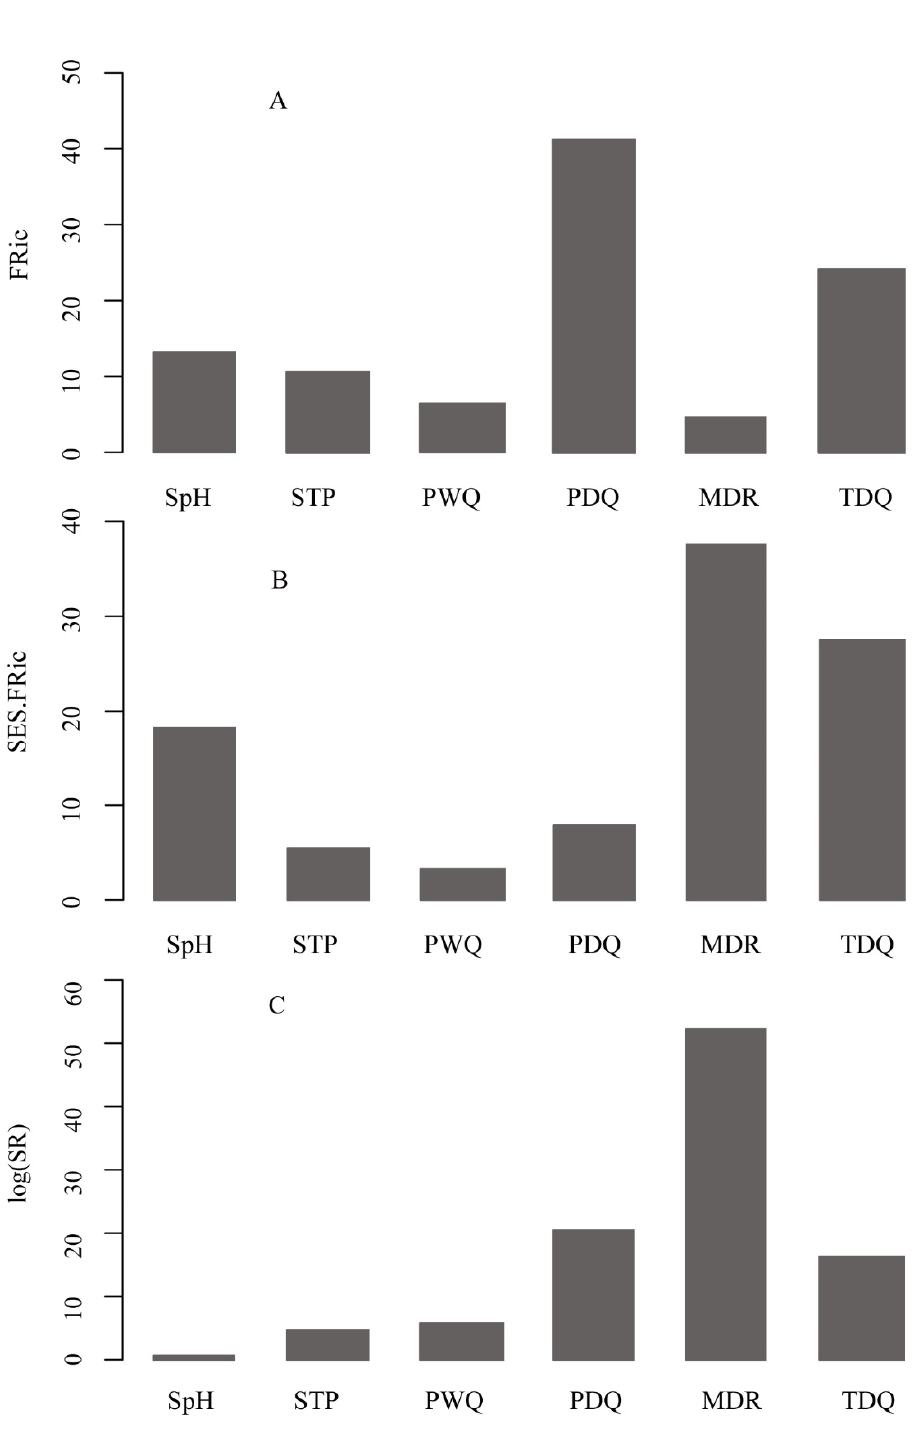
Figure 2. ( A – C ) Summary of hierarchical partitioning results for functional richness (FRic), the standardized effect of the functional richness (SES.FRic), and (log-transformed) species richness [log(SR)]. Each bar is the percentage of the variance obtained by a separate HP analysis for ( A ) FRic, ( B ) SES.FRic, and ( C ) log(SR) by using consistent environmental variables. Abbreviations: precipi- tation of driest quarter (PDQ), precipitation of wettest quarter (PWQ), mean diurnal range (MDR), mean temperature of driest quarter (TDQ), soil pH (SpH), soil total phosphorus (STP).